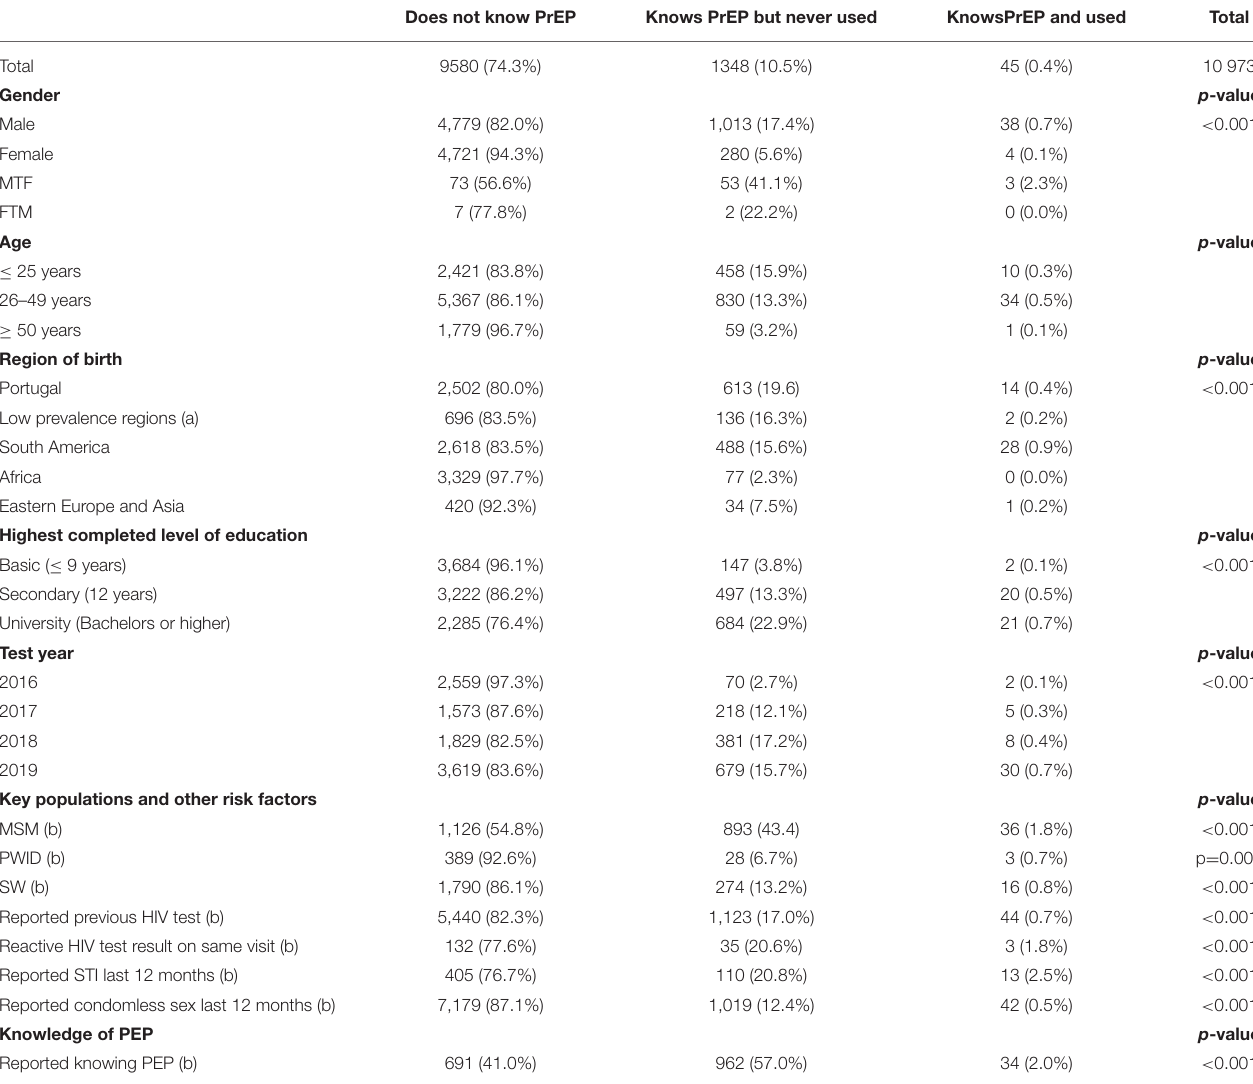
TABLE 2 | Number and percentage of respondents reporting to know